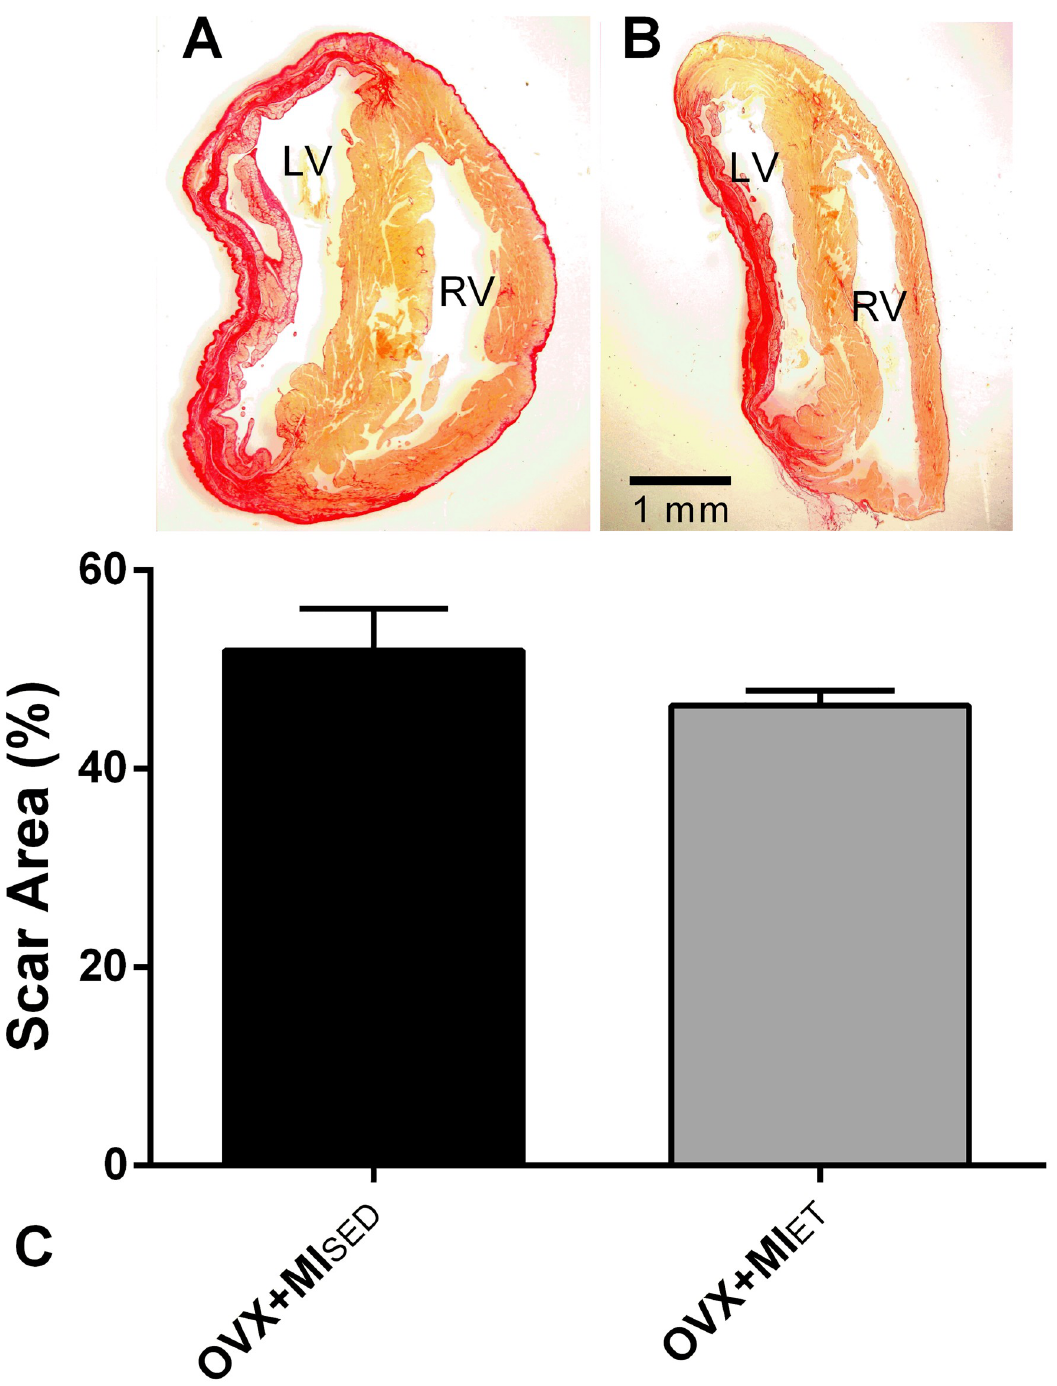
Fig 1. Histological analysis of myocardial infarction area. Area of infarct extension stained with Picrosirius (A and B). Representative graph of the statistical analysis of infarct extension (C). Data are expressed as mean ± SEM (n = 5 and 4, respectively). Unpaired Student´s t-test was used to compare the